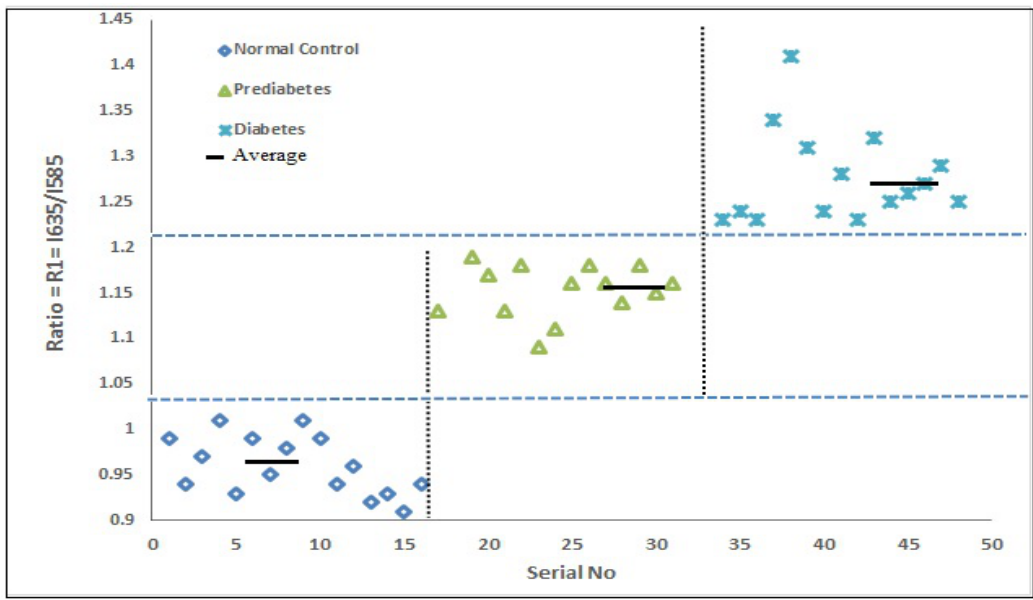
Figure 4. The fluorescence emission spectra (FES) of acetone extract of the red blood cells (RBCs) of (a) normal control, (b) pre-diabetic subjects, and (c) diabetic patients.